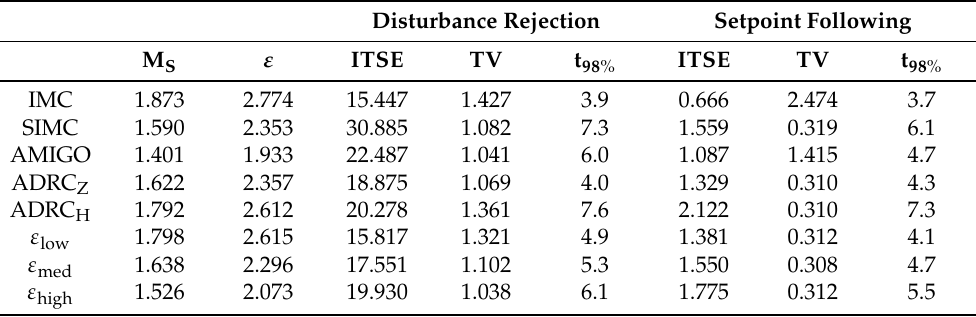
Figure 15. Closed loop time response of G 2 ( s ) with the second-order LADRC tuned with the proposed rules. Comparison with the performance of PID controllers. Table 7. Performance comparison of proposed tuning rules with other tuning methods for control of G 2 ( s ) . For all controllers M T = 1. The ε med controller is more robust and offers a lower ITSE for disturbance rejection than the ADRC Z controller. The three proposed alternatives offers a better disturbance rejection performance than the ADRC H controller with similar or better robustness. Disturbance Rejection Setpoint